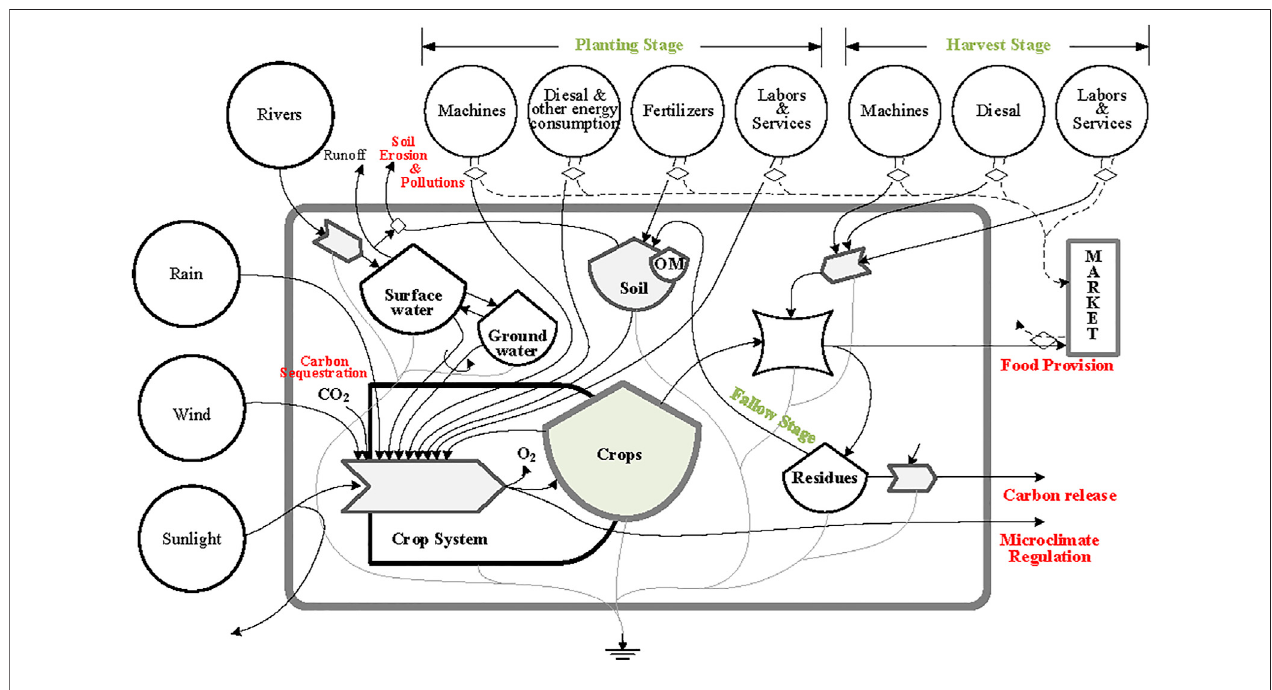
FIGURE 2 | Emergy fl ow diagram of the crop